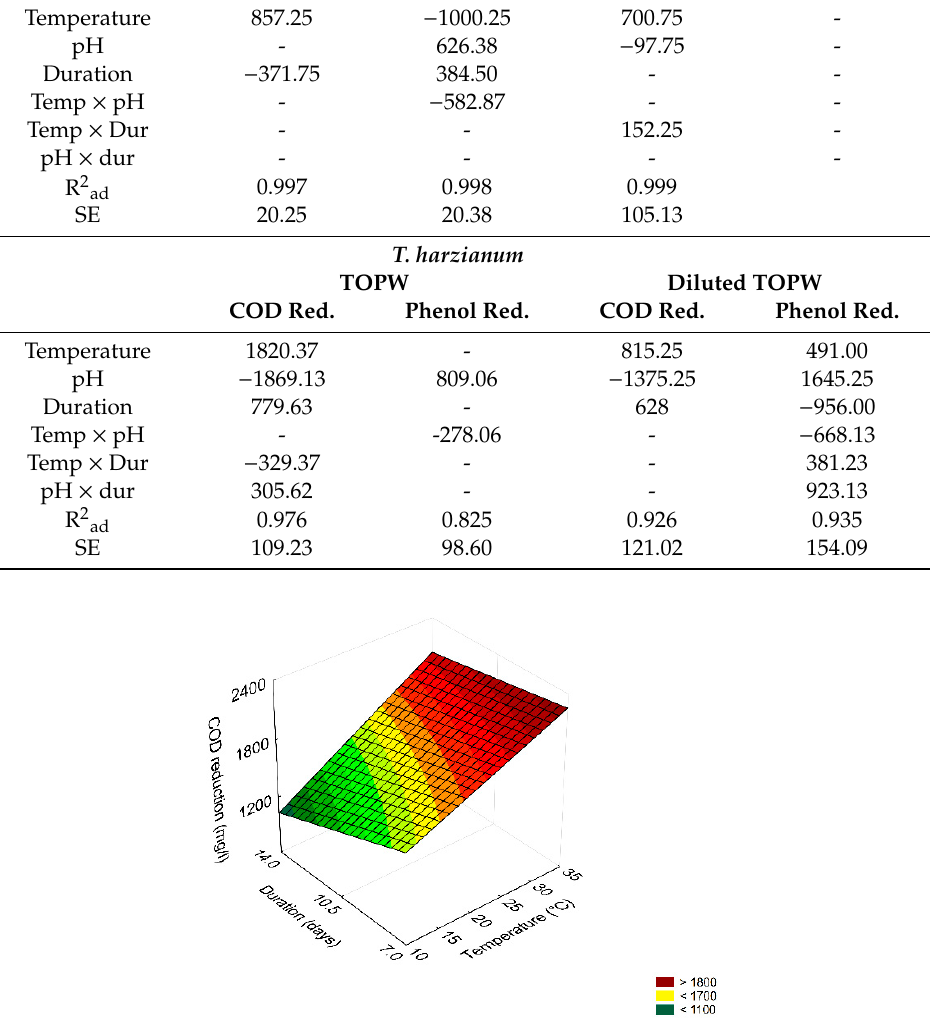
Figure 1. Surface response plot for the interaction duration / temperature on COD reduction by the combination of B. pumilus – C. boidinii strains.